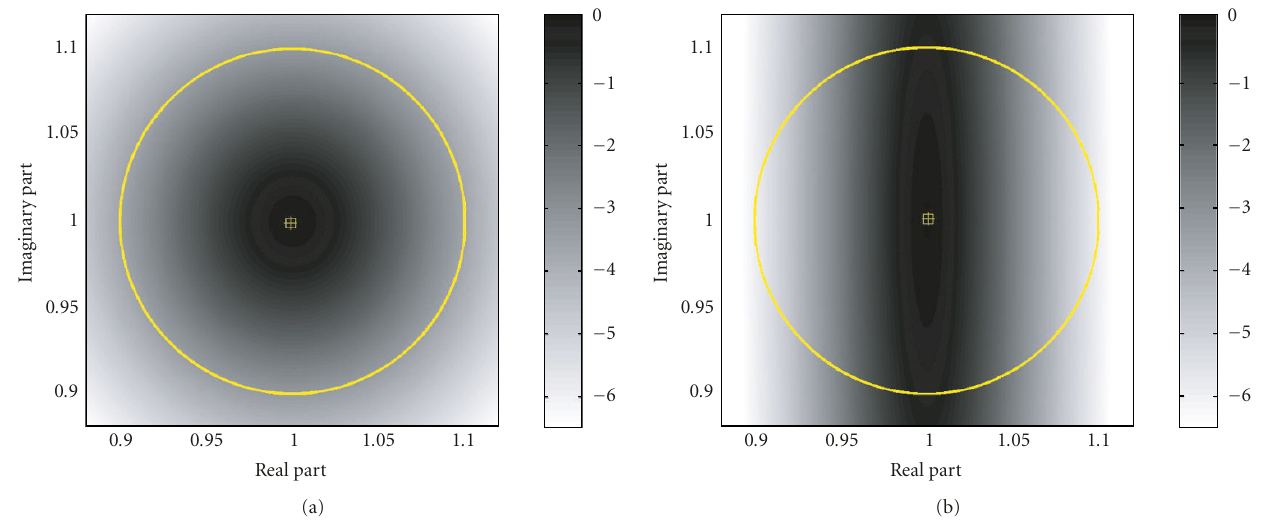
Figure 3: Normalised SNR 10log (SNR( k )/SNR( k W2 )) in dB as a function of real part and imaginary part of k/k W2 for two di ff erent choices 10 of channel coe ffi cients a , b , c , d , n 1 , n 2 . While the SNR decay is in the same order of magnitude for all directions for case (a), the sensitivity of the SNR along the direction corresponding to the imaginary part is negligible for case (b). Coe ffi cients with a mismatch of up to 10%, denoted by the set K 0 . 1 , lie inside or on the marked circle. The plus-marker indicates k W2 and the square-marker indicates k ML .